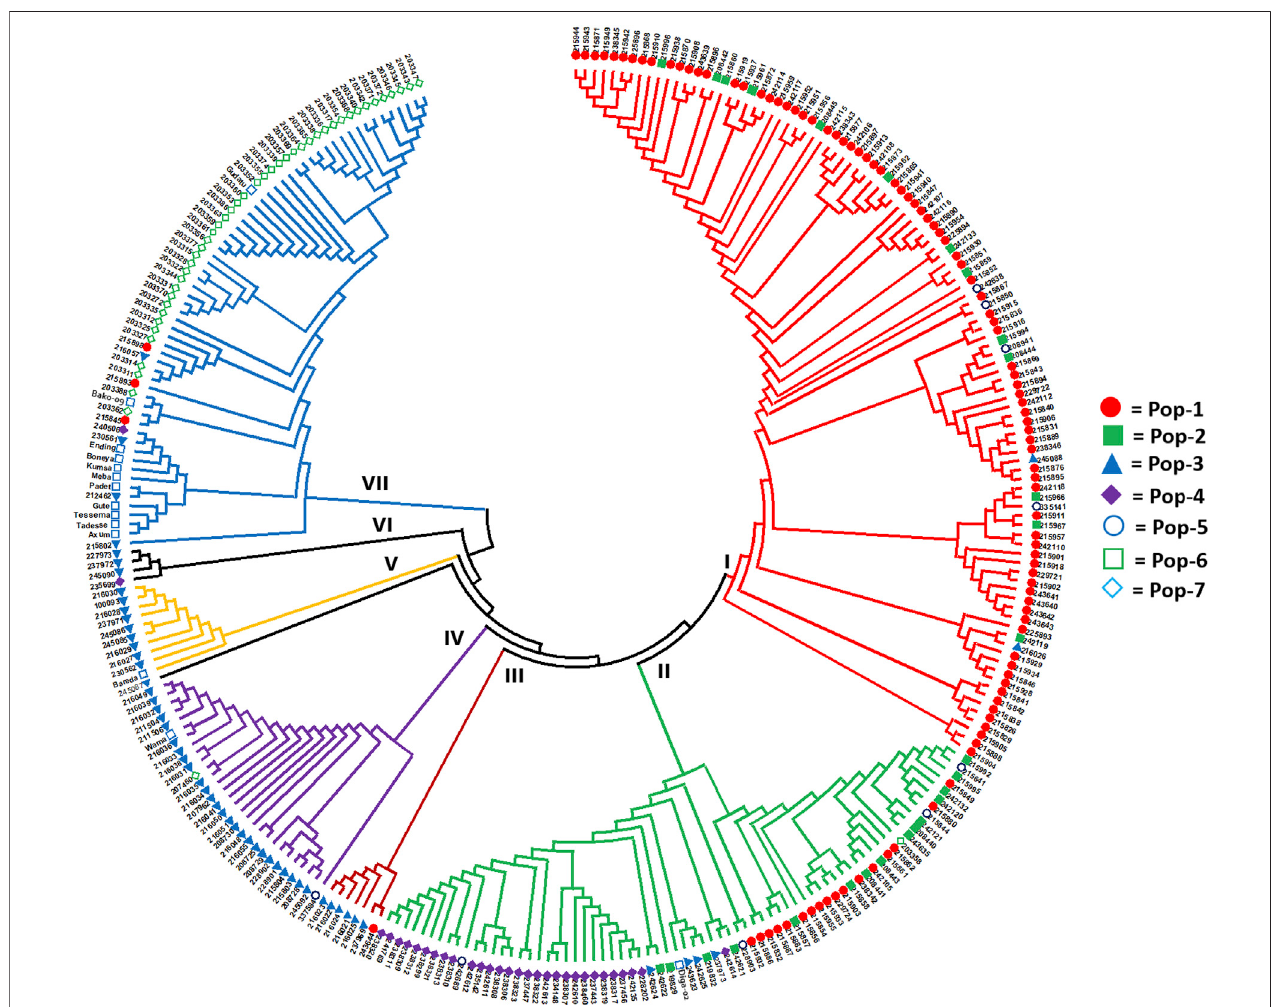
FIGURE 6 | Nei ’ s standard genetic distance-based neighbor-joining tree showing the clustering pattern of the 288 fi nger millet accessions. Accessions sharing a symbol with the same shape and color belong to the same population.